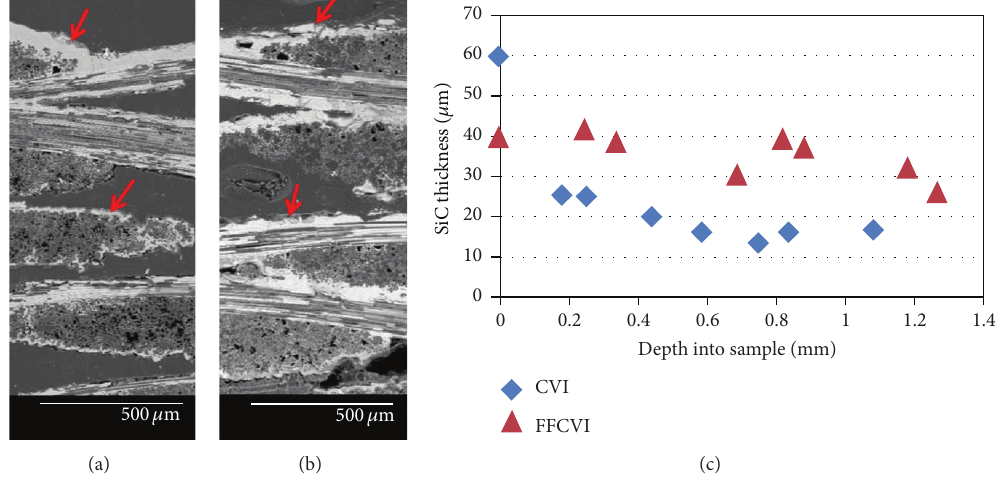
Figure 3: (a) Cross-section of fiber preform partially infiltrated with higher rate isobaric CVI, (b) cross-section of fiber preform partially infiltrated with forced flow CVI, and (c) SiC deposit thickness as a function of depth into the sample for CVI and FFCVI.